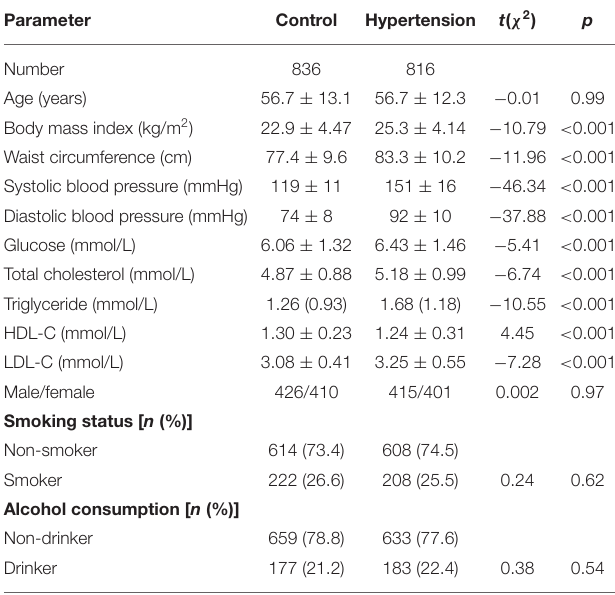
TABLE 1 | General characteristics of the study